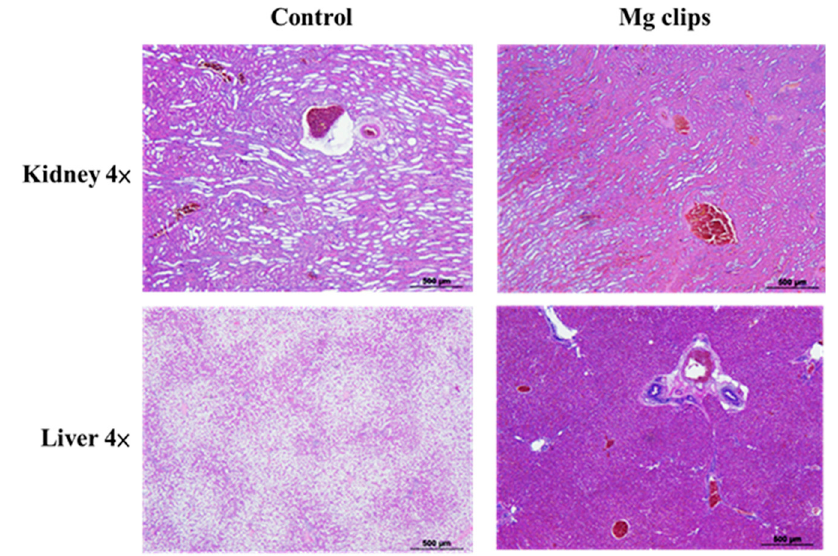
Figure 11. Histological photographs of hematoxylin-and-eosin-stained sections of tissues.